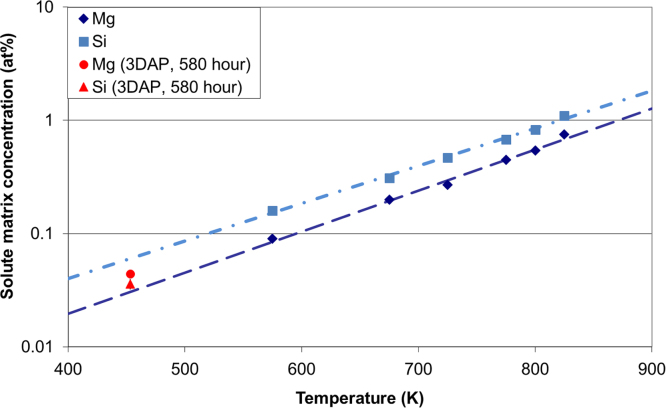
Solid solubility limits (in at%) of Mg and Si in aluminium in Al–Mg–Si system. Values on the dark blue and pink lines are from [42].